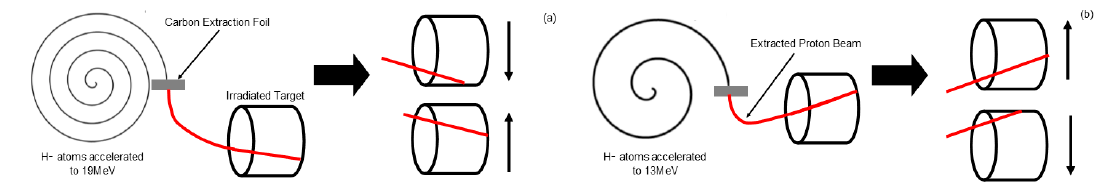
Figure 5. Illustrations comparing the 19 MeV ( a ) and 13 MeV ( b ) extractions and the resulting beam steering effects. The arrows indicate target movement in the left-right direction.